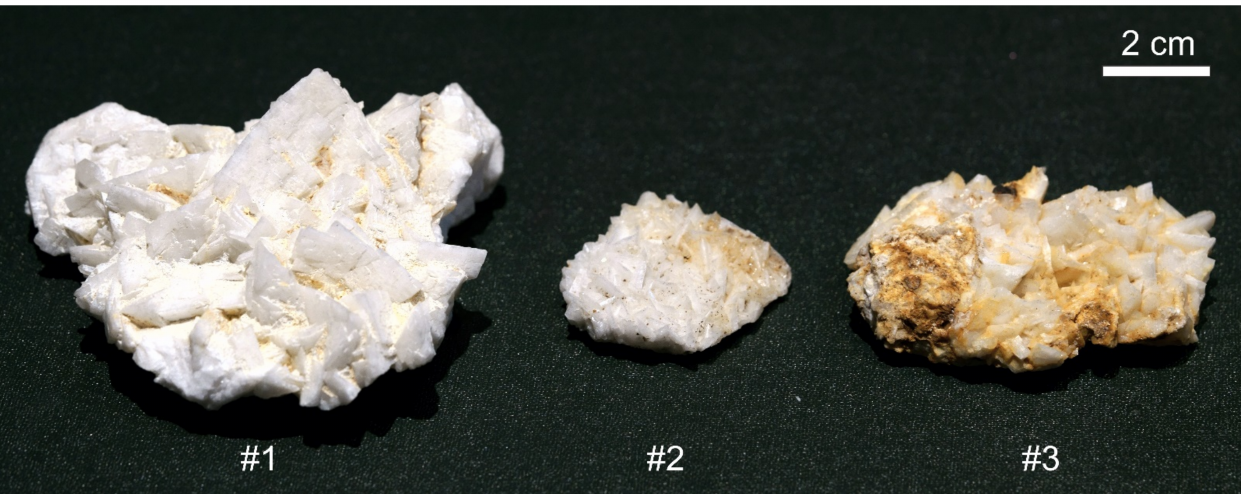
Figure 2. Valencianite hand samples studied in this work. All specimens from the La Valenciana mine, Guanajuato, Mexico. Table 1. Technical data for the X-ray diffractometer used for the Rietveld refinement. Parameter Value X-ray diffractometer Shimadzu XRD-6000